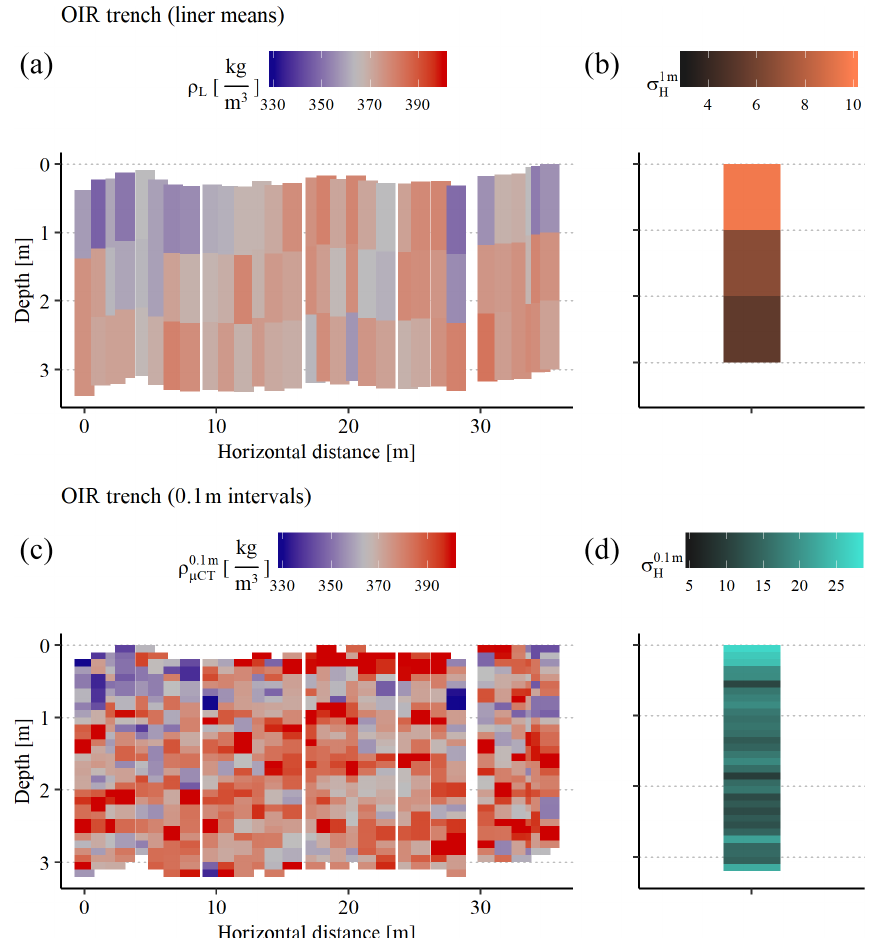
Figure 5. Density of the OIR trench from 30 profiles in vertical 1m (liner density, a, b ) and 0.1m sampling intervals ( µ CT density, c, d ) in a color-coded plot. For the profiles in 0.1m intervals, we used a common depth scale for the whole trench starting at the top of the profile with the highest surface elevation (profile 30); all other liners start at the measured relative height. We then calculated the density of each 0.1m interval according to the common depth scale. ρ L and ρ 0 . 1m , respectively, are given in a blue (low density) to red (high density) color code. µ CT On the right of each panel, σ H of the respective depth interval is